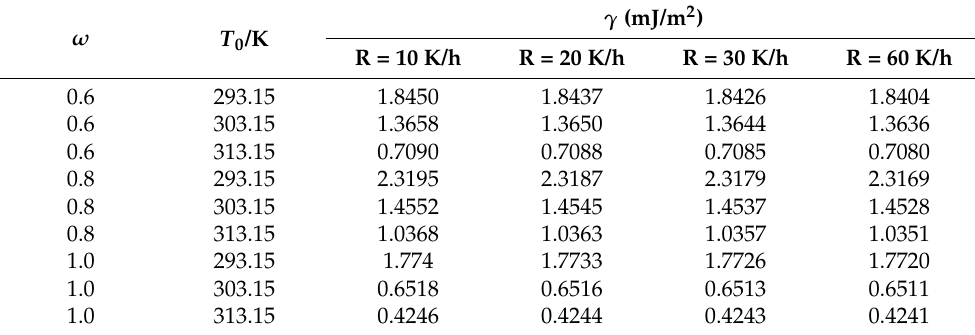
Table 4. The interfacial energies γ (mJ/m 2 ) fitted by the Sangwal